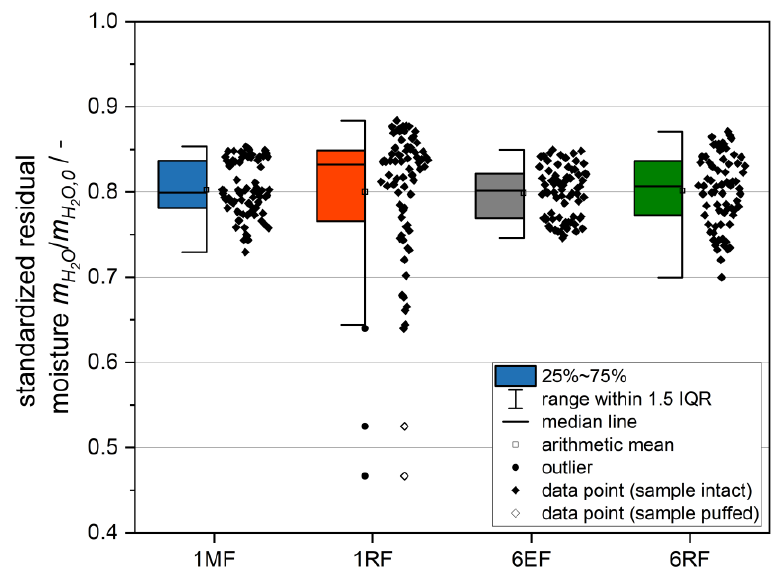
Figure 13. Distribution of residual moisture after MFD for the different control concepts standardized 5 to the water mass in the samples before drying. The data sets consist of experiments in triplicate for each control concept with 24 samples each. The colors match the control concepts in analogy to the previous figures. IQR–interquartile